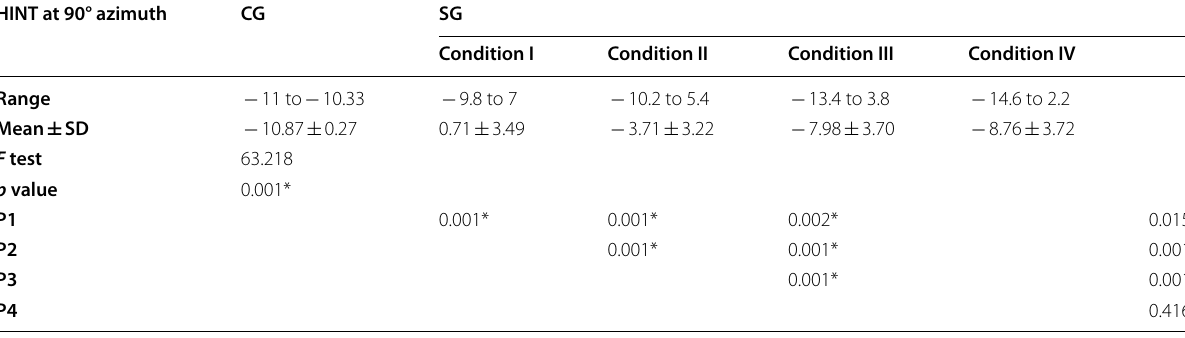
Table 4 Comparison among CG and SG conditions I, II, III, and IV using noise at 90°